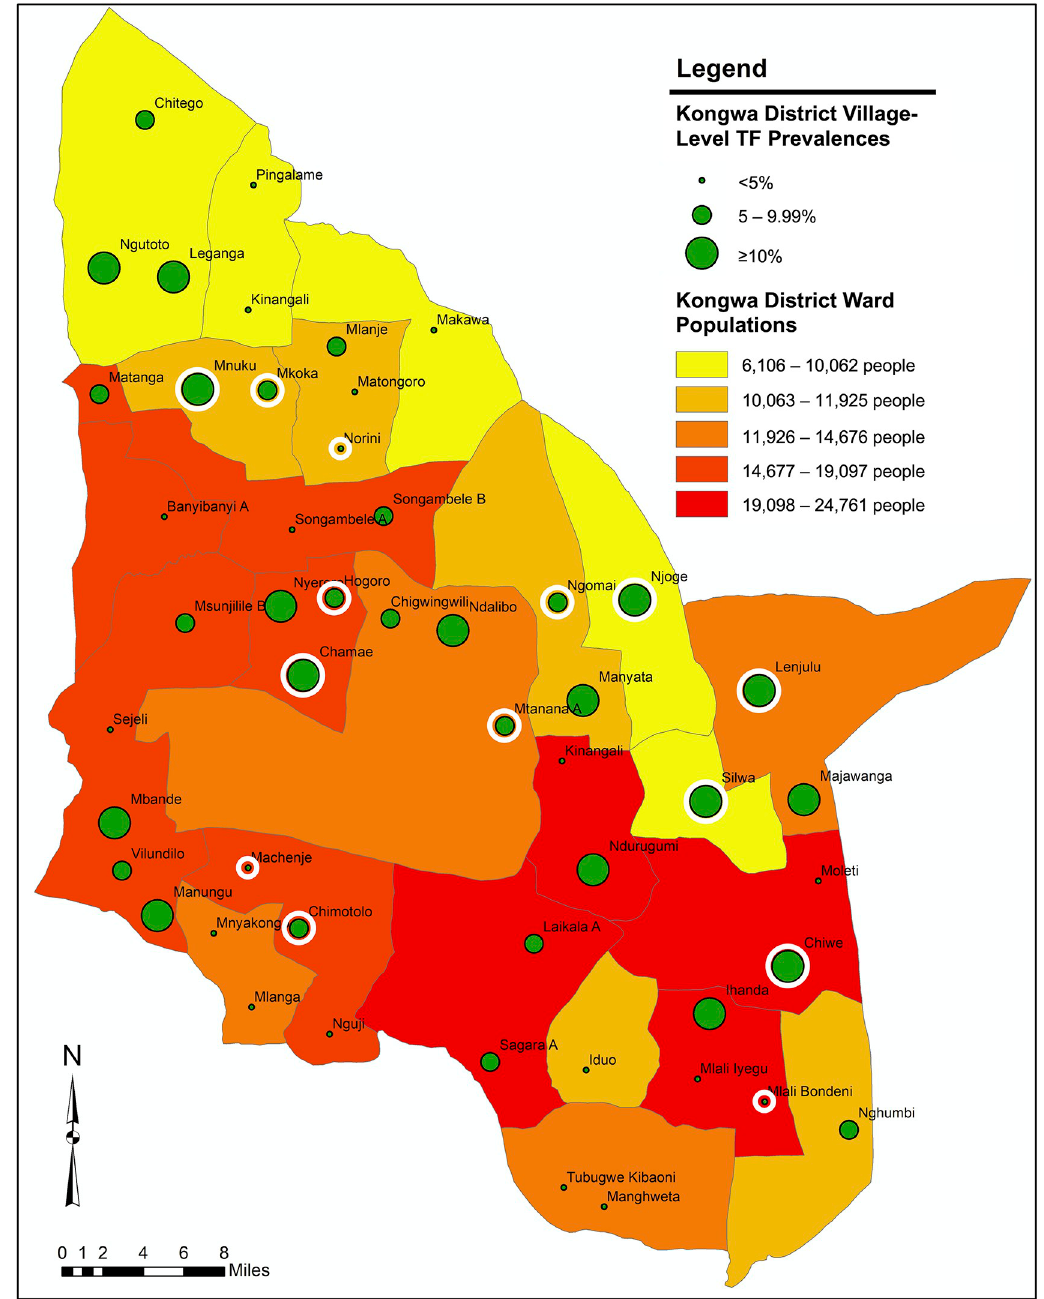
Fig 5. Geographic distribution of village-level TF prevalence in children ages 1–9 years in Kongwa District, Tanzania. The circular white borders indicate villages that also had percent seropositivity > 10% in children ages 1–2 years. Base map from Humanitarian Data Exchange: